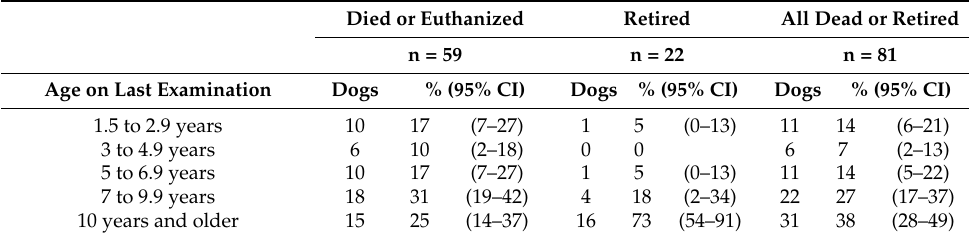
Table 5. Age on last examination of 81 dogs enrolled in TeamMate that were reported as having died or been retired from